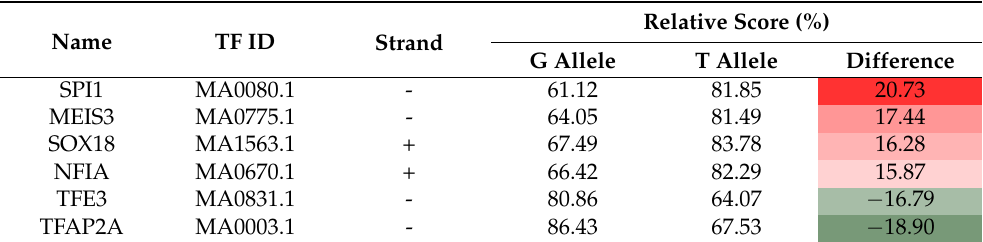
Table 2. List of transcription factors that were affected by rs6841081 polymorphism. Positive values of relative score differences on a red background indicate that the minor allele increased the TF binding probability, negative values on a green background indicate that the minor allele decreased the TF binding probability. A darker shade indicates that there is a larger